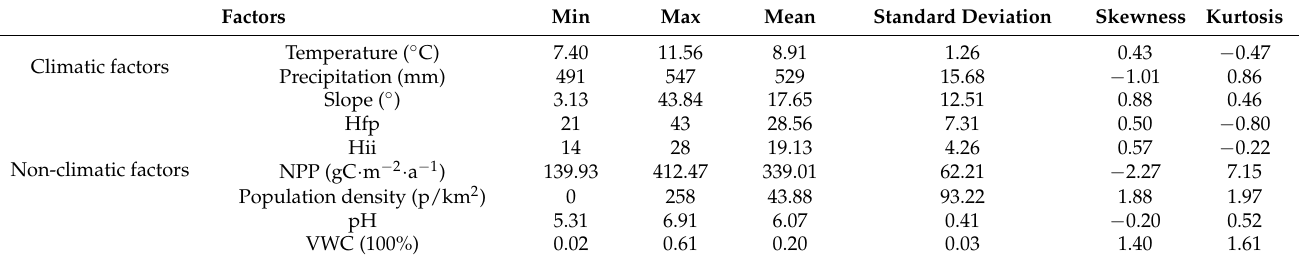
Table 1. Descriptive statistics of climatic and non-climatic factors along the vertical gradient of Taihang Mountain study area in northern